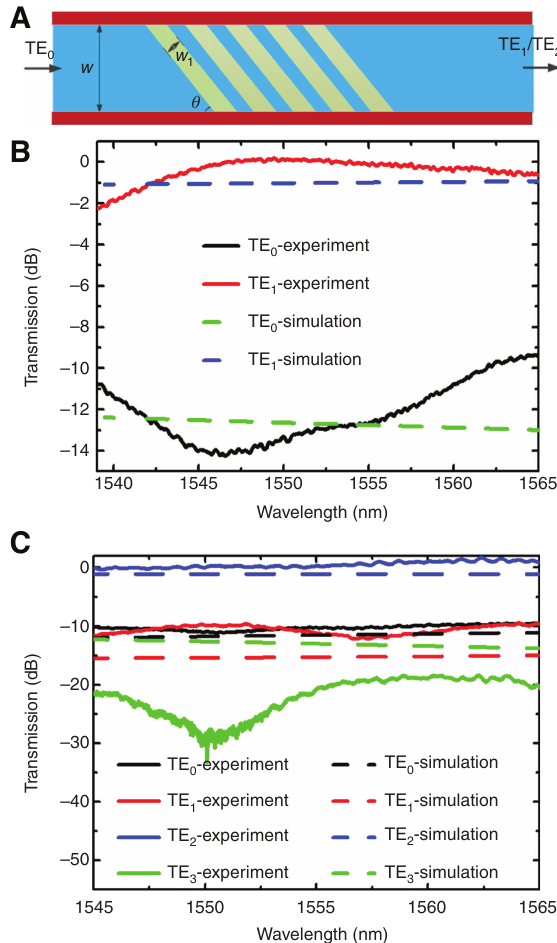
Figure 13: Experimental demonstration of a mode-order converter with tilted subwavelength slots. (A) Schematic diagram of the mode-order converter. The blue, yellow, and dark red colors represent silicon, partially etched silicon, and silica, respectively. Measured transmission spectra of (B) a fabricated TE -to-TE mode converter and (C) a fabricated TE 0 1 to-TE mode converter compared with simulation results. Reprinted 2 from Wang et al. [57]. Copyright © 2019 by John Wiley and Sons.